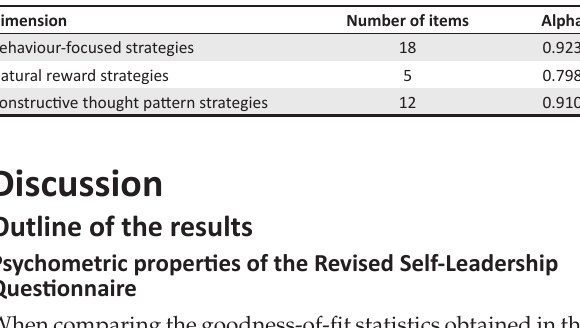
TABLE 3: Reliability estimates for the three dimensions (RSLQ, n =